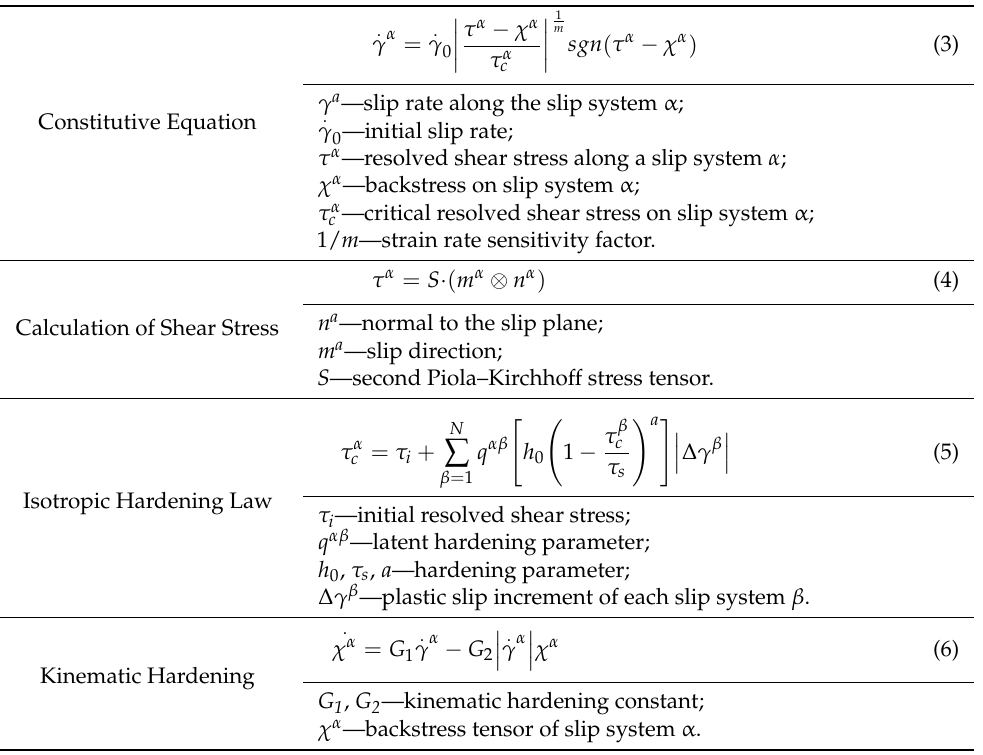
Table 3. Main equations in the CP model.